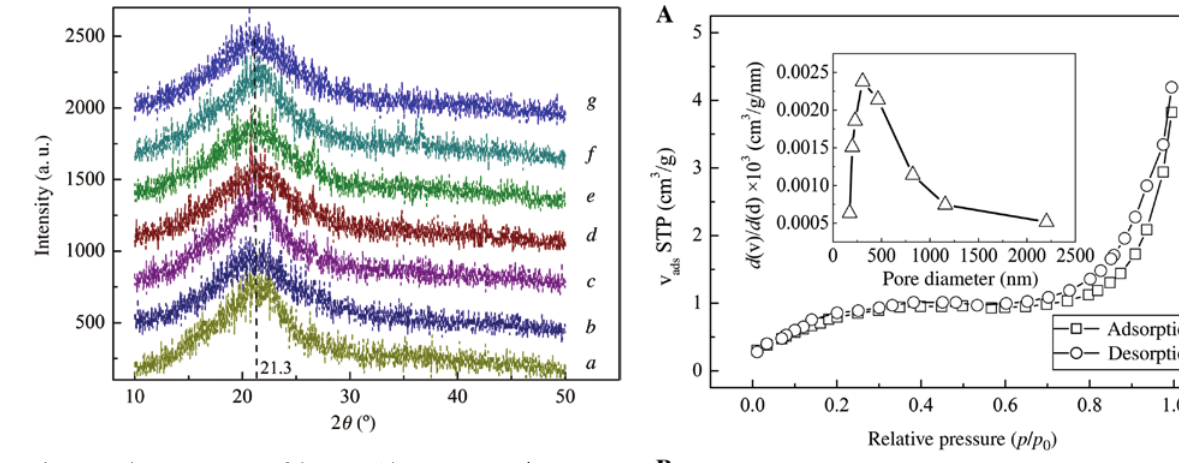
Figure 5: The XRD patterns of the SVR without treatment (curve a ), and with treatment by sulfuric acid (curve b ), sodium sulfite (curve c ), sulfamic acid (curve d ), benzenesulfonic acid (curve e ), p -toluenesulfonic acid (curve f ), and sodium laurylsulfate (curve g ), respectively.